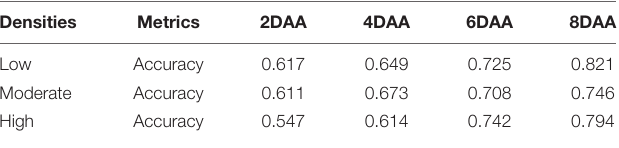
TABLE 5 | Resistant weed classification performance summary of different